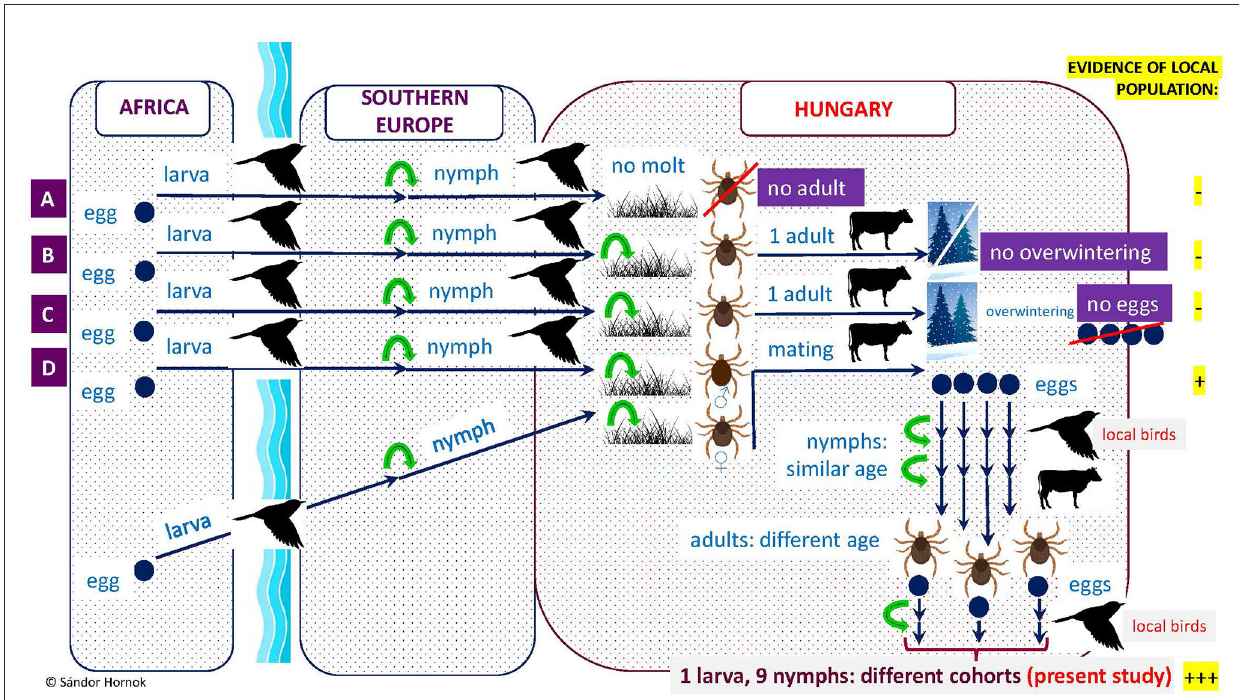
FIGURE2 Illustration of the possible consequences of bird-borne transportation of Hyalomma rufipes into countries north of the Mediterranean Basin, including Hungary. Green arrows indicate molting. (A) Nymphs transported by birds may die after drop-off, or (B) molt to adult which cannot overwinter, or (C) if they overwinter as adults, females will not produce eggs in the absence of previous mating, or (D) if nymphs carried by birds detach and molt to male and another (carried independently) to female and these meet and mate on cattle, females will be able to lay eggs after drop-off. First generation larvae and nymphs developing from these eggs probably will have a similar state of engorgement but molting to adults they will find host and will mate at different time. Therefore, existence of a second generation may involve the simultaneous presence of larvae and nymphs of different cohorts on local birds, as shown in this